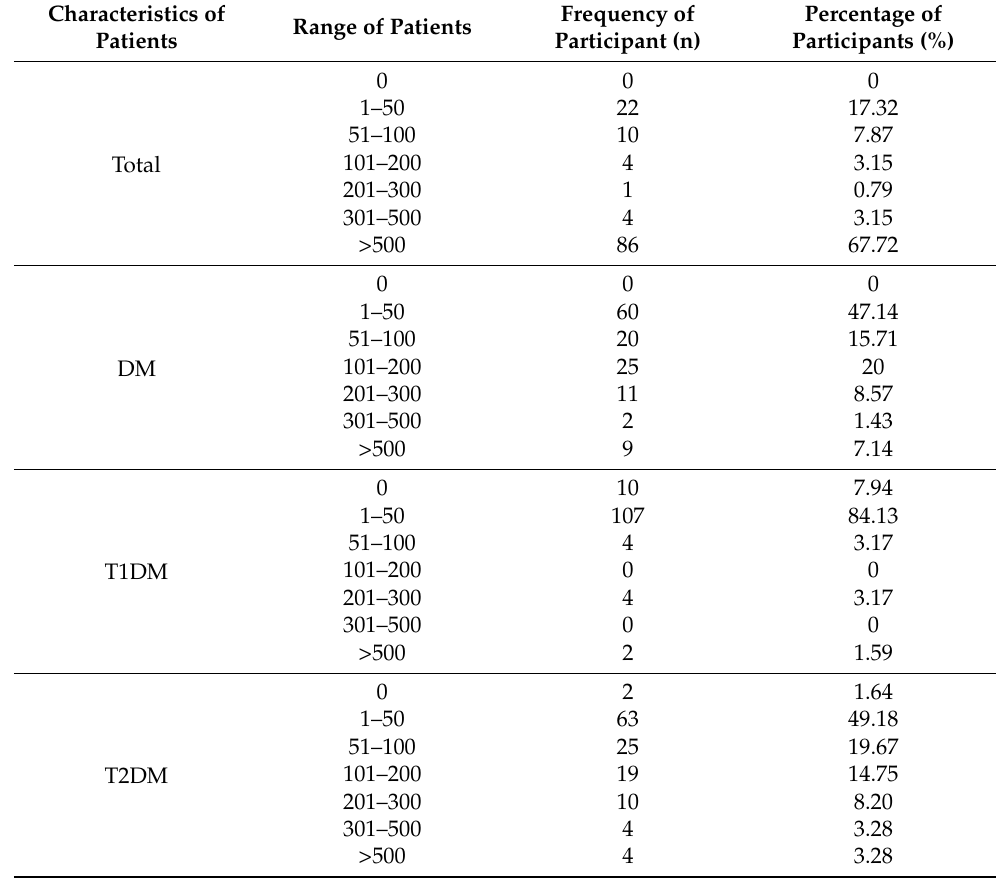
Table 2. Total patients with T1DM or T2DM (n = 127).